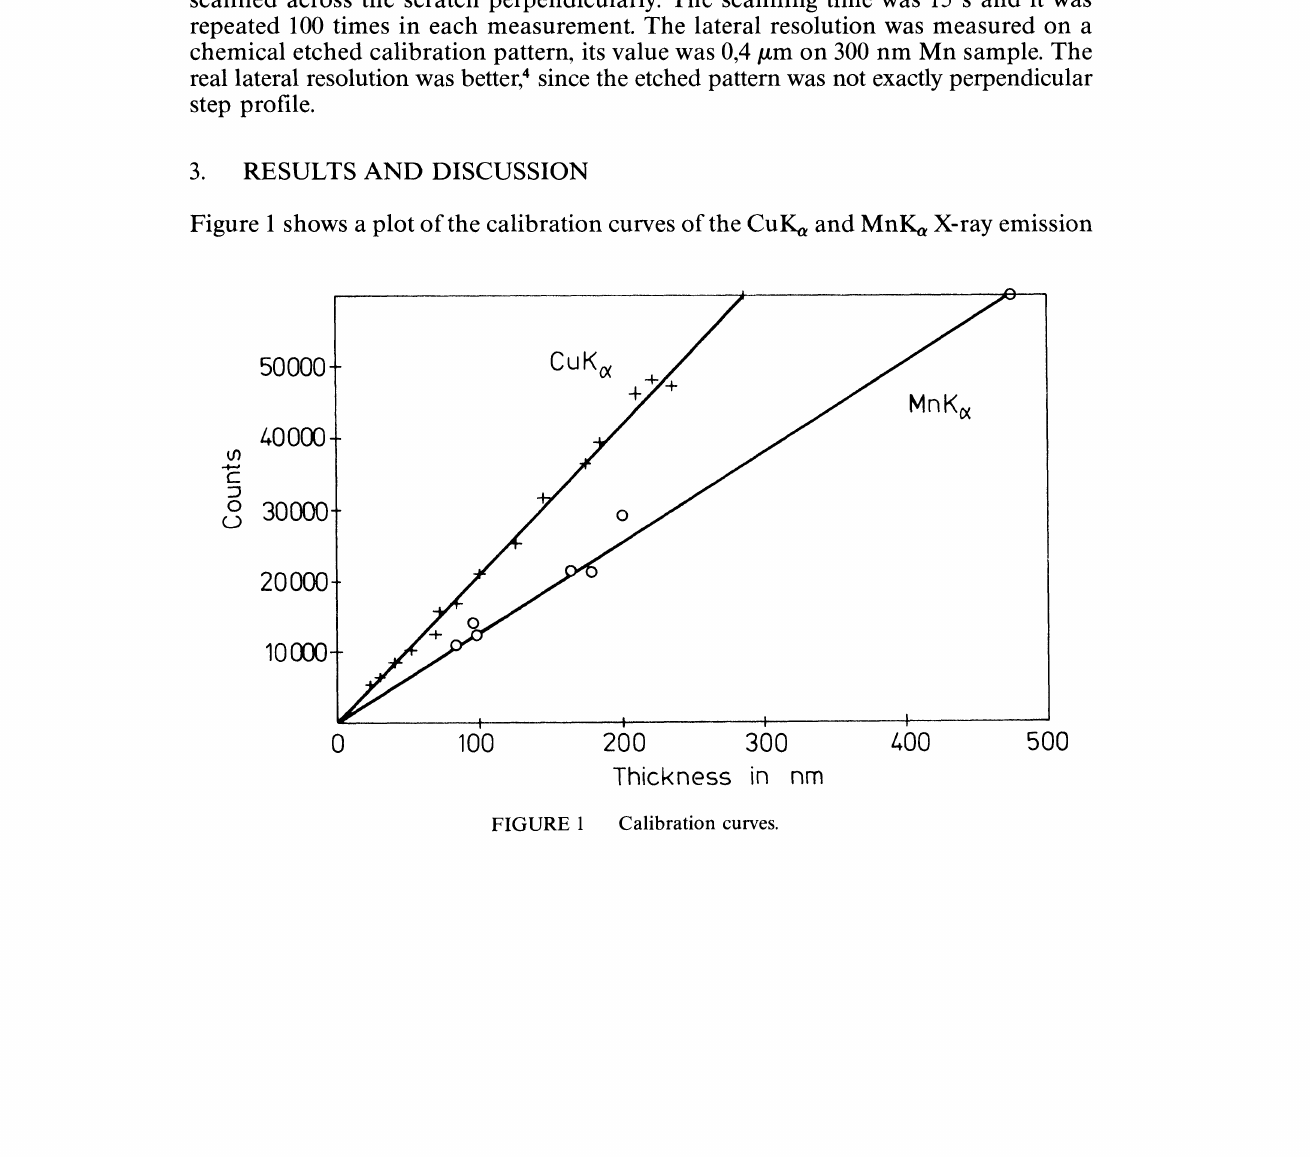
FIGURE Calibration